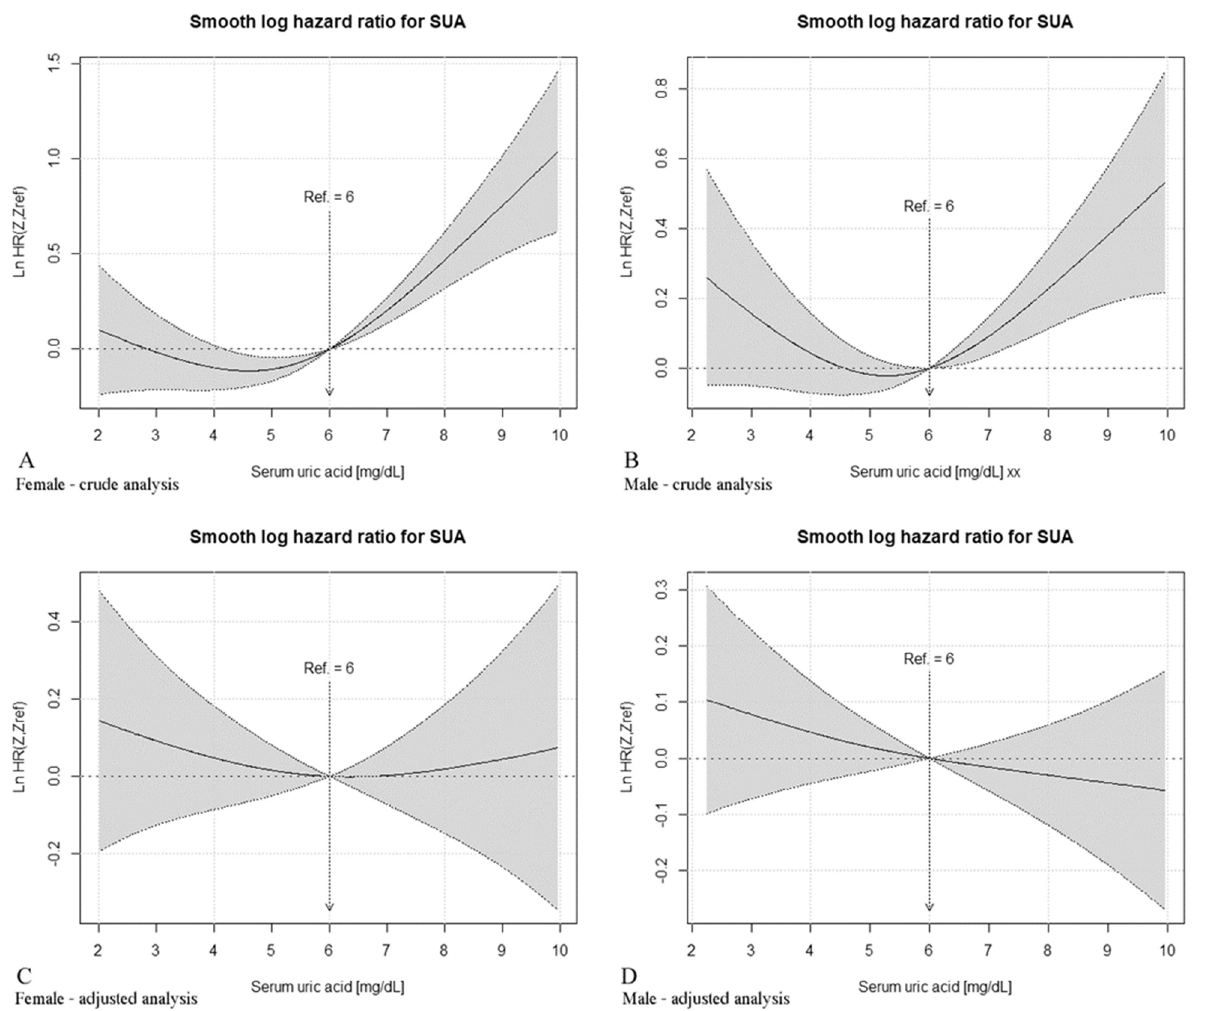
Figure 3. Adjusted and unadjusted nonparametric estimates of the dependence of all-time risk of death on SUA level without a prior diagnosis of diabetes mellitus among women and men (log hazard ratio, with 95% confidence limits). ( A ) The crude analysis for female; ( B ) The crude analysis for male; ( C ) The adjusted analysis for female; ( D ) The adjusted analysis for male.